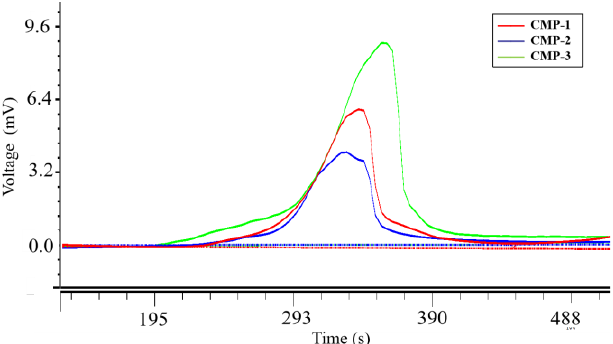
Figure 2. High performance gel permeation chromatography of CMP-1, CMP-2 and CMP-3.